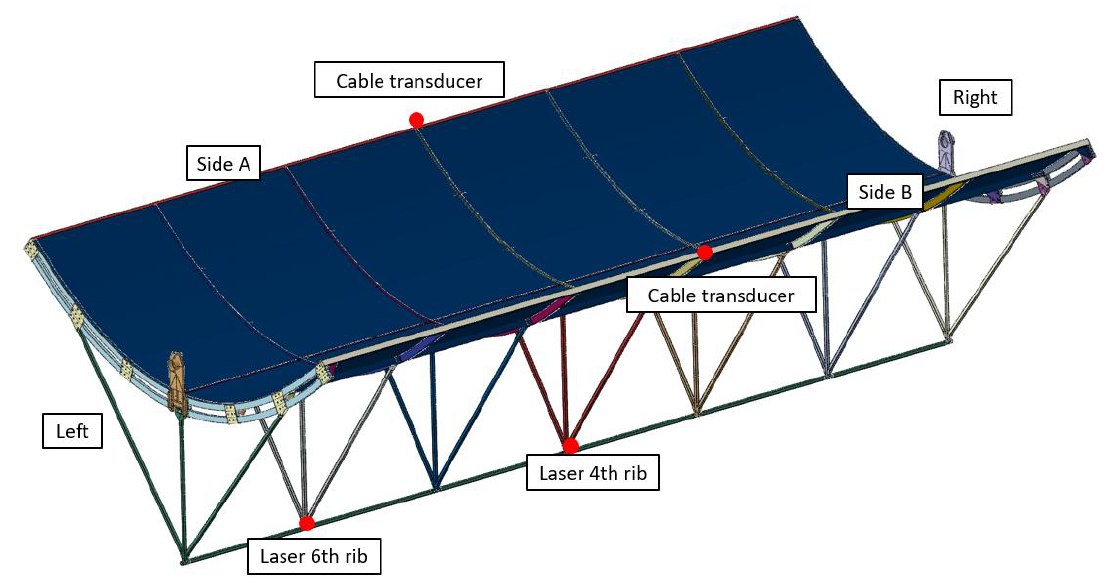
Figure 17. Summary of the measurement instruments and their location for wind load test.